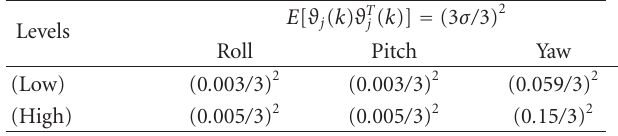
Table 2: Standard deviation of the star sensor measurement noise levels around each